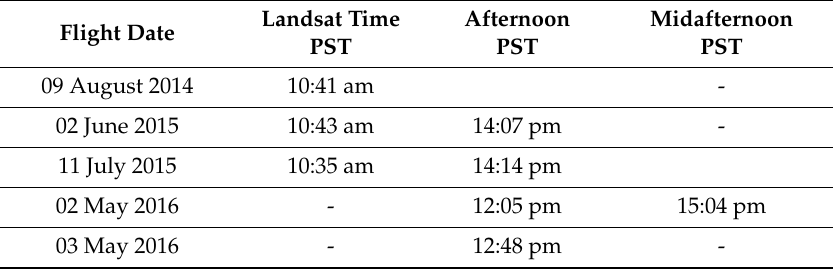
Table 1. Dates and times of AggieAir GRAPEX flights used in this study.